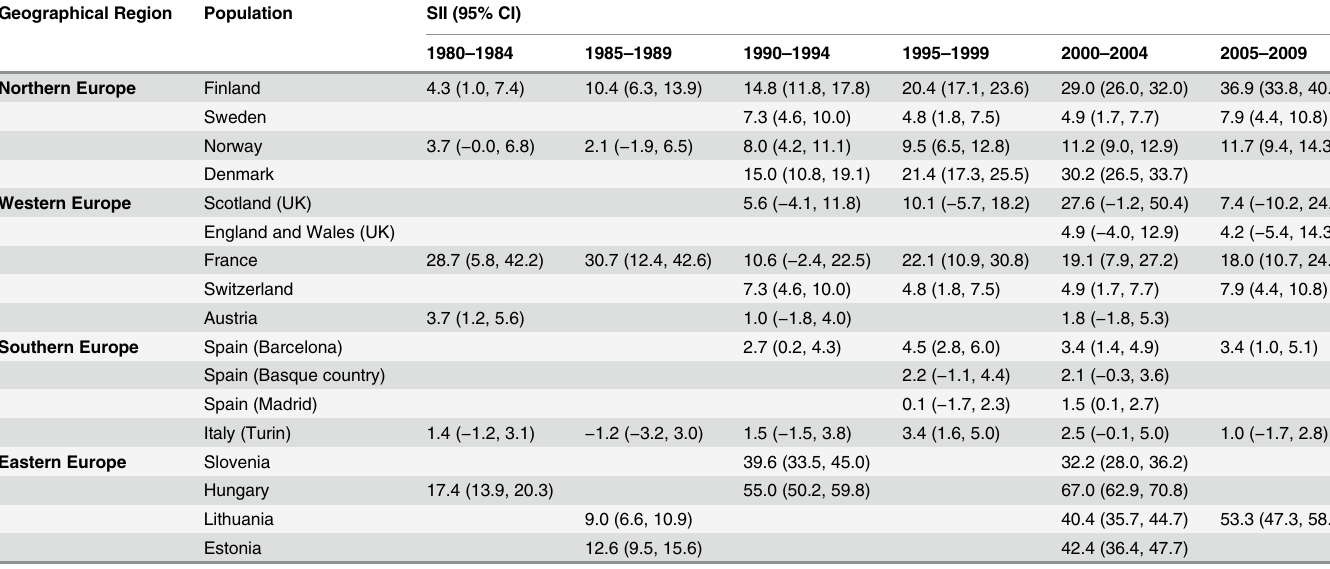
Table 8. Trends in SII for educational inequality in mortality from alcohol-related causes among women aged 35 – 79 y, ca. 1980 – 2010, by population. Geographical